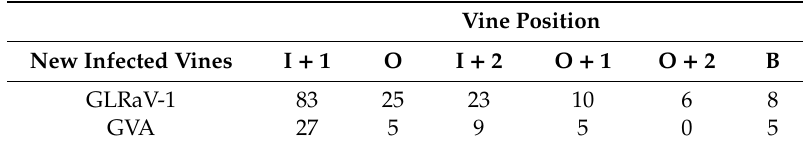
Table 2. Numbers of new infected vines in 2009–2014 according to their position around vines previously infected (I) in 2003–2008. I + 1: first neighbour within the same row, I + 2: second